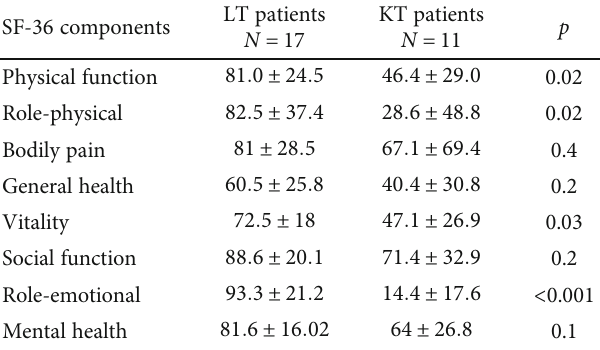
Table 3: The eight-item SF-36 scores in LT and KT patients 12 weeks (T12) after the end of DAA therapy. Data are expressed as mean ± standard deviation